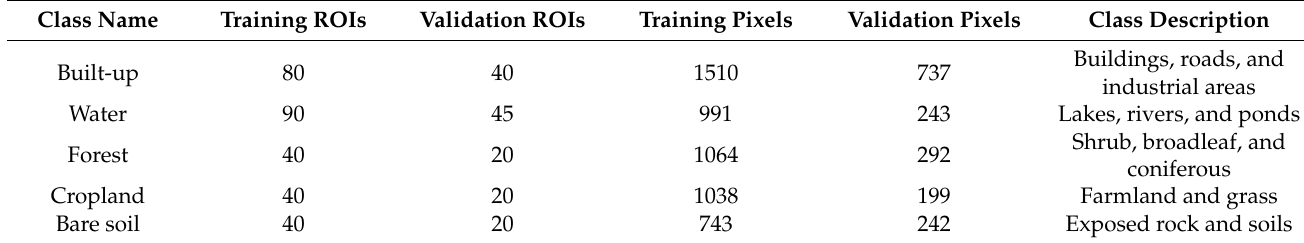
Table 1. Description of five land cover